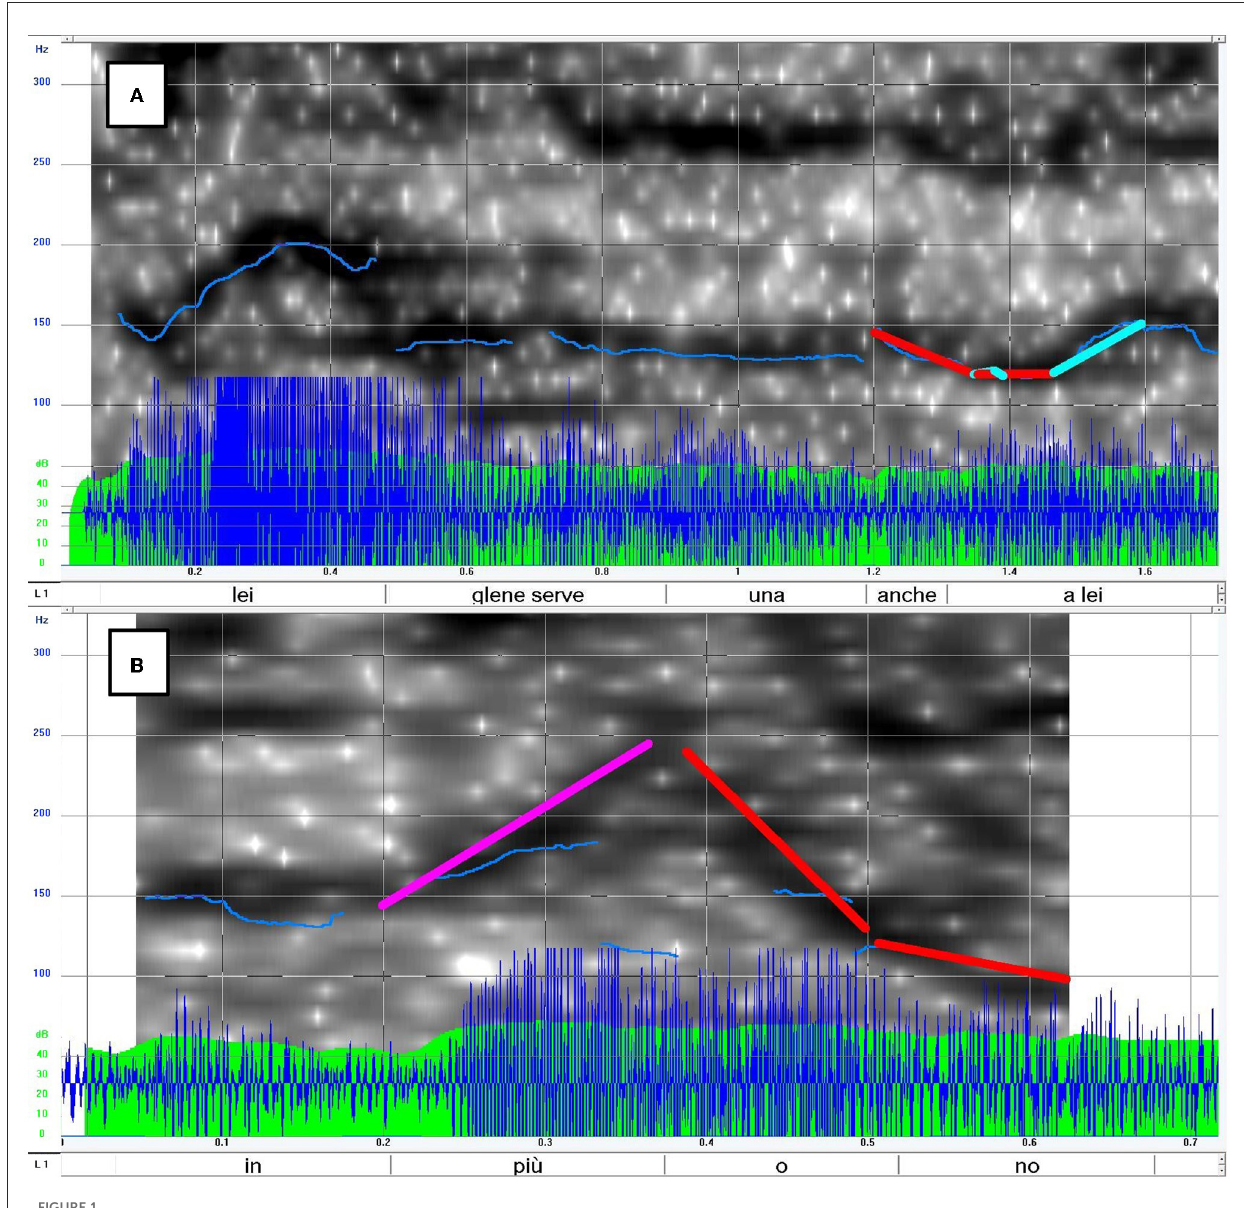
FIGURE1 The comment and the illocutionary pattern (A, B) (Supplementary Audio